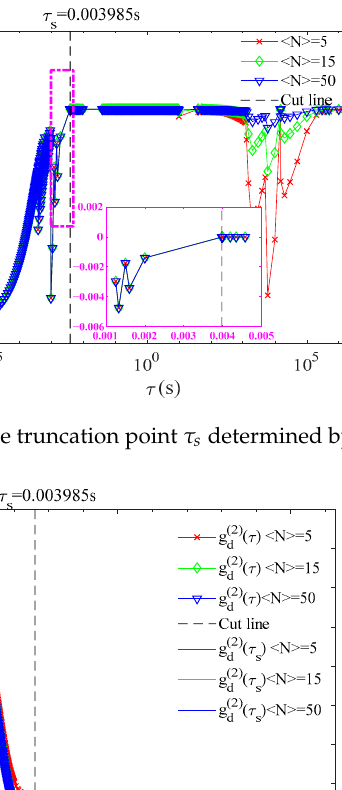
To determine a new, adjusted baseline, we can examine the change in adjacent channels ( 2 ) ( τ ) and find the truncation point where g ( 2 ) ( τ ) at τ ≥ t of g c . Figure 2 shows the d (cid:0) (cid:1) − (cid:0) (cid:1) ( 2 ) ( 2 ) g τ j + 1 τ j difference between adjacent channels, g , with the delay time of g ( 2 ) ( τ ) . d d (cid:0) (cid:1) − (cid:0) (cid:1) ≤ ( 2 ) ( 2 ) ( 2 ) ( τ ) has decayed to g (cid:48) ( τ ) , the effective g τ j + 1 τ j At τ j = τ s , when g 10 − 3 , g d d d baseline term due to number fluctuations. The new ACFs, g ( 2 ) ( τ ) , with new baseline ( 2 ) ( τ ) are obtained as shown in Figure 3. Then, g ( 1 ) ( τ ) is calculated by the usual Siegert g s d relation and the PSD is obtained by Equation (7). In the actual DLS measurement, four (cid:1) ≤ (cid:0) (cid:1) − (cid:0) ( 2 ) ( 2 ) g τ j τ j + 1 consecutive delay channels are required to satisfy g 10 − 3 in order to d d minimize the effect of noise on the ACF in choosing the correct baseline point.